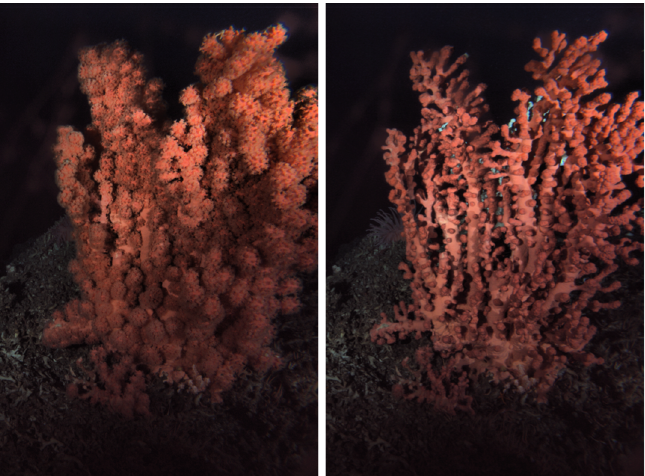
Figure 3. Different activity statuses for the coral as bloated (left; for polyp extrusion) and non-bloated (right; polyp retraction), as revealed after Contrast Limited Adaptive Histogram Equalization (CLAHE) image enhancement.